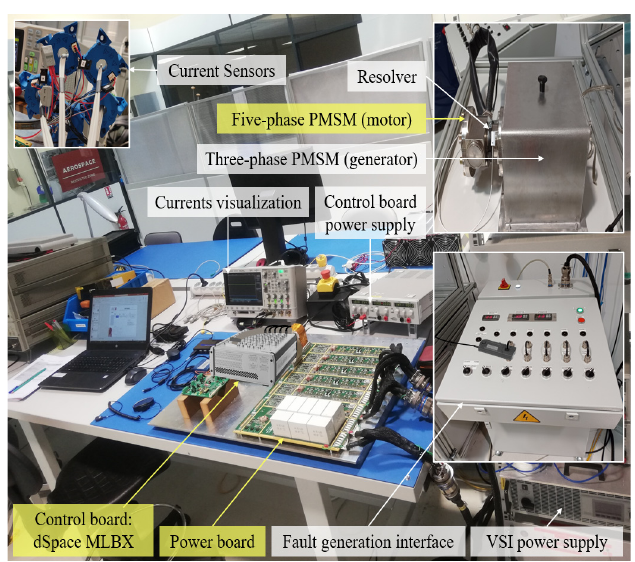
Figure 2. Overview of the experimental test bench.